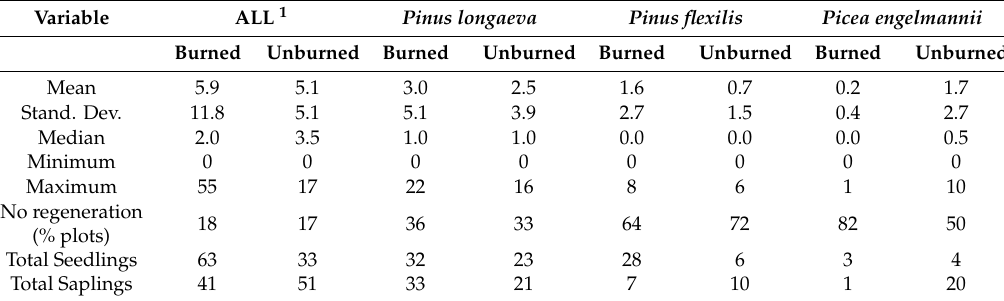
Table 2. Summary of regeneration counts (i.e., total seedlings and saplings) for plots inside (“Burned”) and outside (“Unburned”) the 2000 fire perimeter. ALL 1 Pinus longaeva Pinus flexilis Picea